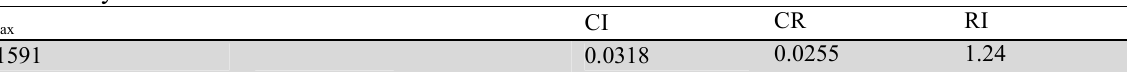
Consistency Rate